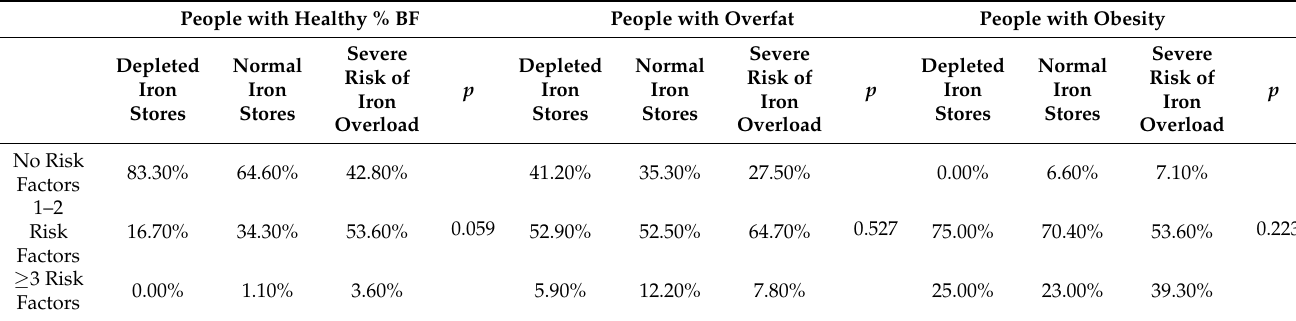
Table 5. Risk of metabolic syndrome between iron status groups across categories of % BF. People with Healthy % BF People with Overfat People with